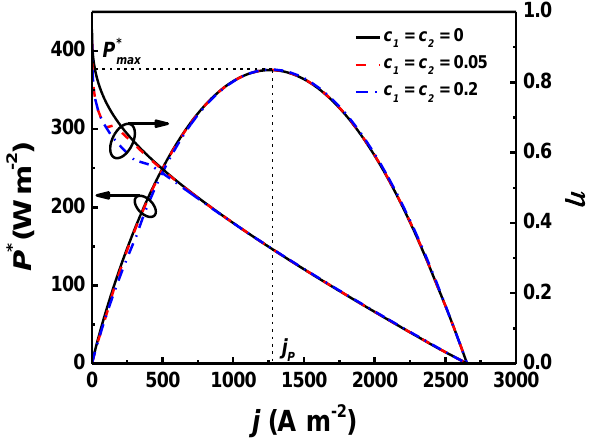
c c and 2 on the hybrid system